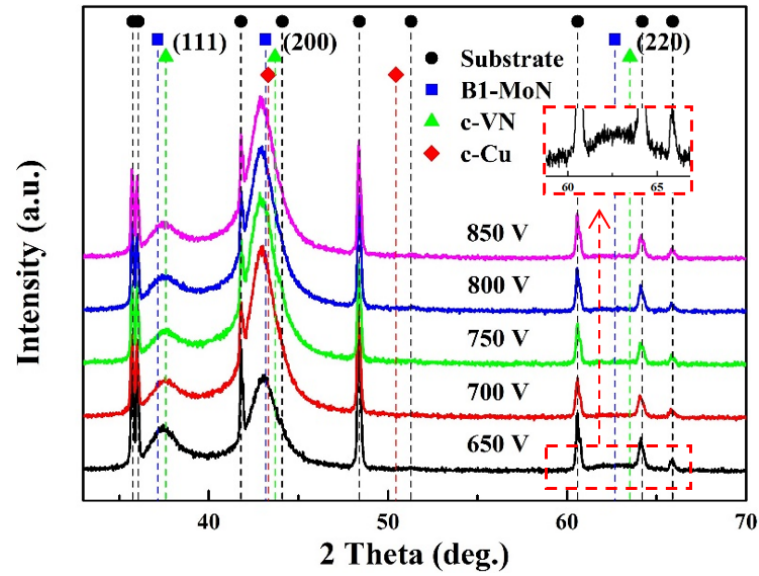
Figure 4. XRD patterns of Mo–Cu–V–N coatings at various charge voltages. Table 2. Lattice parameters of Mo–Cu–V–N coatings at various charge voltages. Phase Lattice Parameter a 0 (Å)